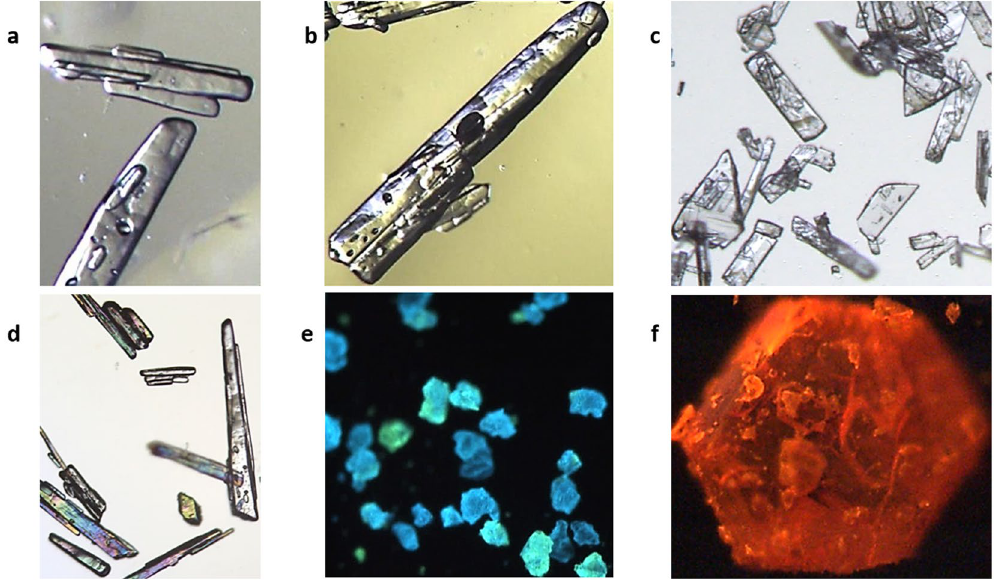
Figure 2. Particle imaging with a low-cost assembly for enhanced contrast and surface definition. Images in this figure do not constitute a focus-stack, and are snapshots cropped from larger field of view images (1.7 × 1.42 mm 2 ). ( a and b ) Taurine crystals (360 and 850 µ m, respectively). ( c ) Thin L-glutamic acid crystals (130 µ m). ( d ) Taurine crystals (150 µ m) viewed with cross polarizer films. ( e ) Strontium aluminate phosphorescent particles (80 µ m). ( f ) Phosphorescent crystal of [Ru(bpy) 3 ]Cl 2 (440 µ m). ( a – d ) were in white backlight in Fig. 1, middle, while ( e – f ) were taken in the dark using UV in Fig. 1, right, on a glass